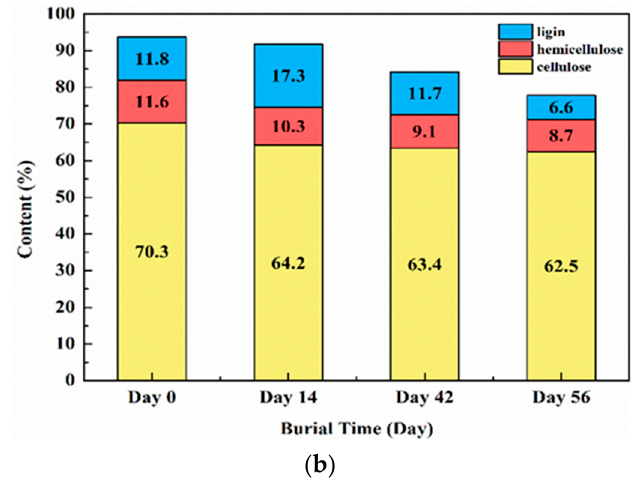
Figure 6. Infrared spectrum and three-element content images of environment-friendly bamboo fiber lunch box in different degradation stages: ( a ) infrared spectrogram; ( b ) three-element content.